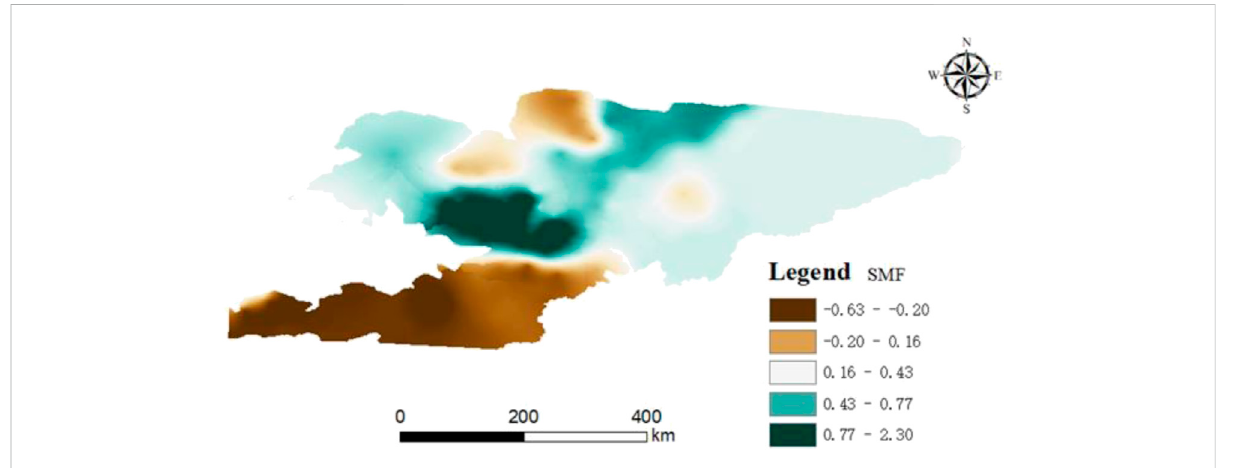
FIGURE 7 Maps of the spatial variability of soil